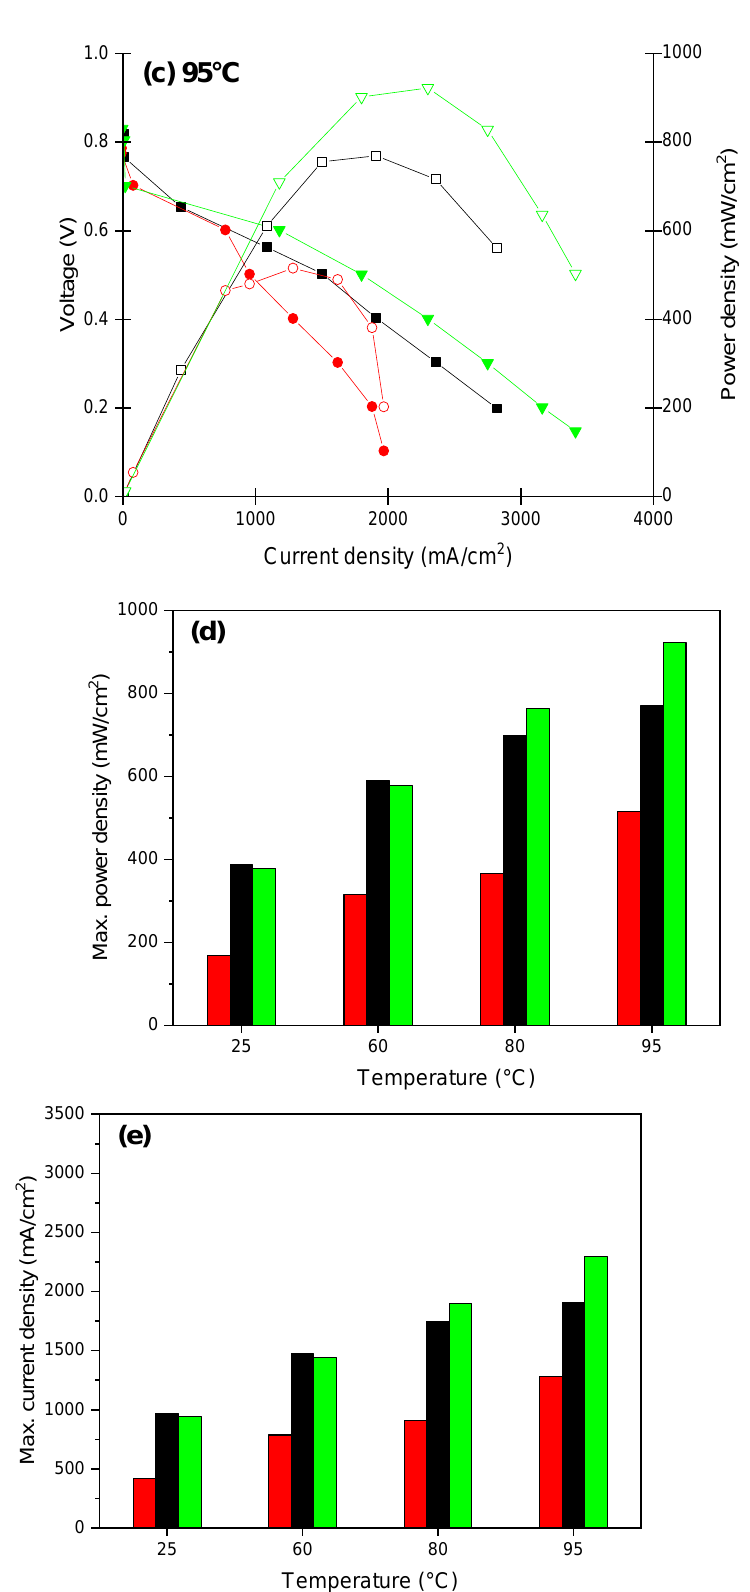
Figure 12. Influence of temperature on the single cell performance. Polarisation and power density curves at ( a ) 25, ( b ) 60, and ( c ) 95 °C, respectively, ( d ) maximum power density and ( e ) maximum current density at 0.4 V. Recast Nafion membrane (red), Nafion XL commercial membrane (black), and Nafion membrane with 10 wt.% tungsten oxide (green).